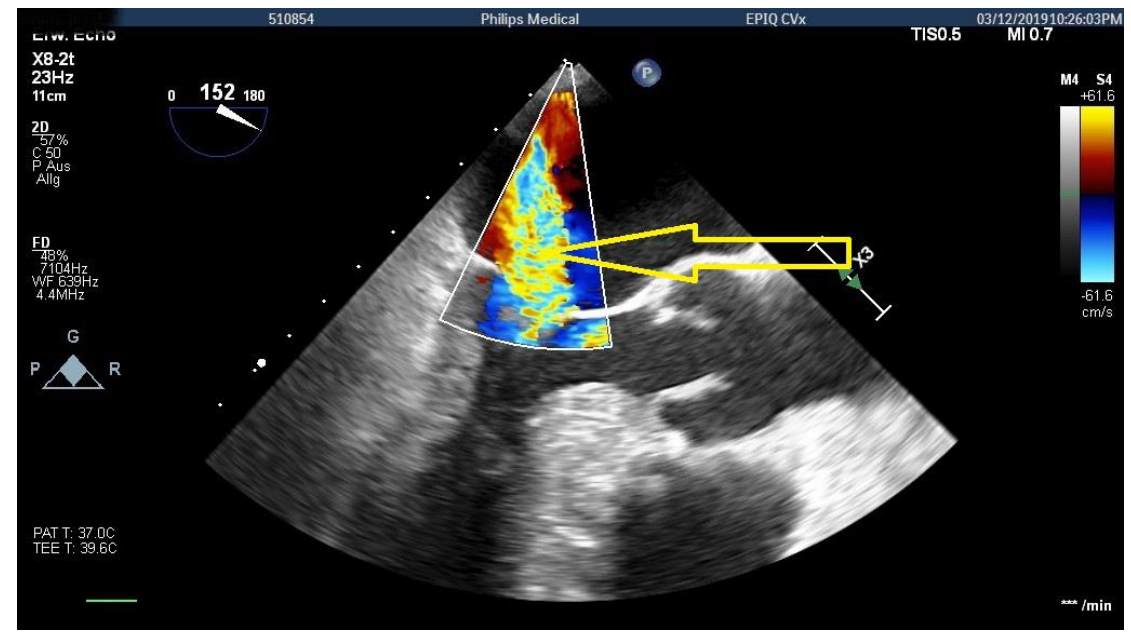
Figure 3. High-grade mitral regurgitation (indicated by yellow arrow). On redo surgery the left ventricular outflow tract was only mildly thickened but looked blood-shot. Two muscle blocks each about 1 cm in width and length and 4–5 mm